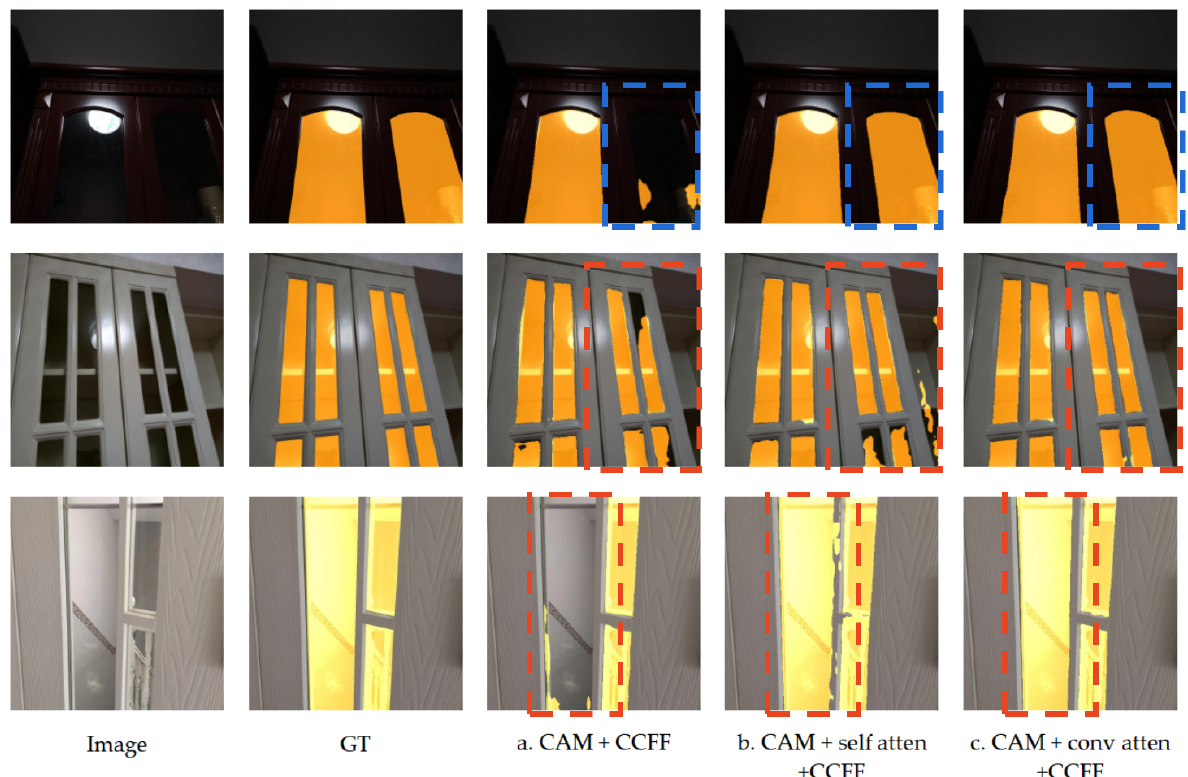
Figure 12. Comparison of the results of CCFF module ablation experiments; ( a ) is the result of using only C-ASPP, ( b ) of using C-ASPP and MHB, and ( c ) of using C-ASPP + TCH + MHB.